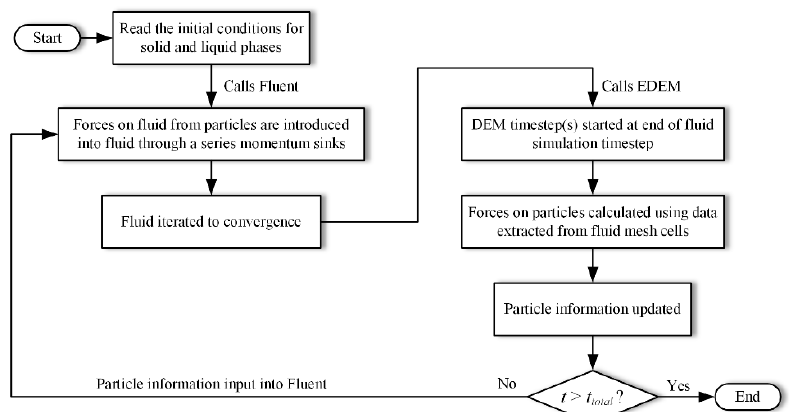
Figure 2. Flow chart for EDEM-Fluent coupling.